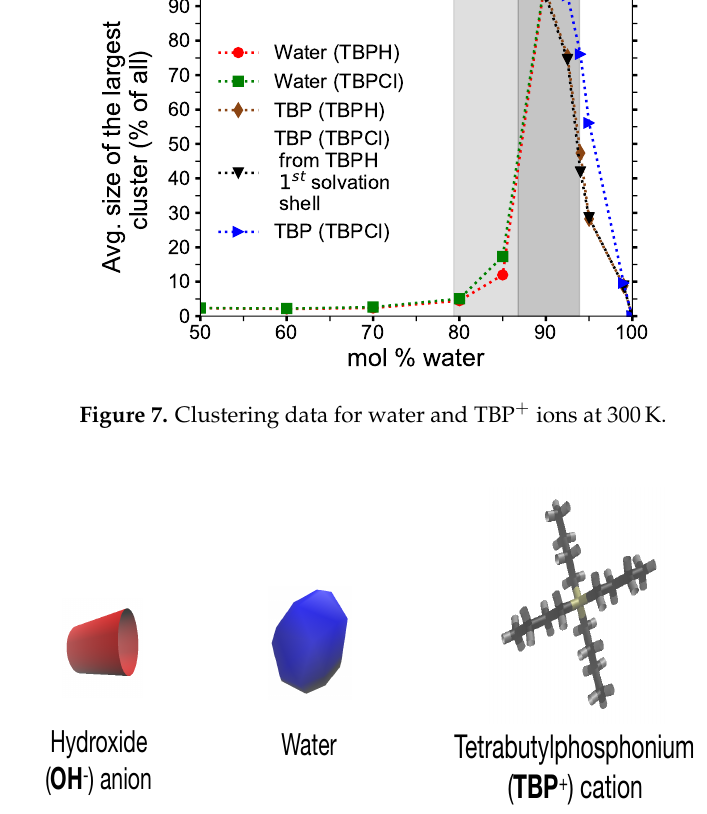
Figure 8. Representation of molecules in the TBPH–water solution. The blue-colored water is represented using an isosurface (called quicksurf in VMD [13]), which uses a volumetric Gaussian density map of the water to produce the observable surface. The TBP and OH molecules are represented using dynamic bonds in VMD [13]. TBP is colored tan, black and gray, for the phosphorus, carbon, and hydrogen atoms, respectively. The hydroxide is colored in red for both the oxygen and hydrogen